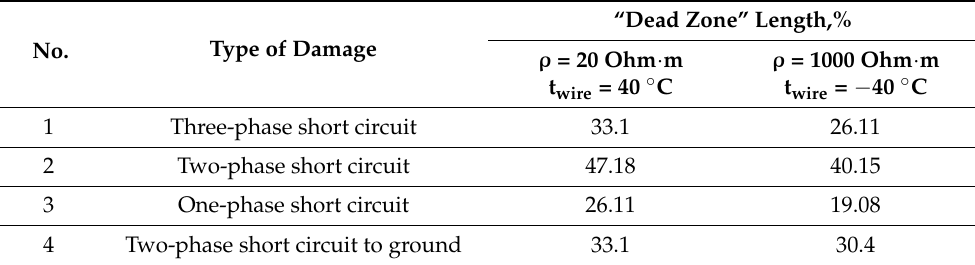
Table 1. The “dead zone” length for various soil